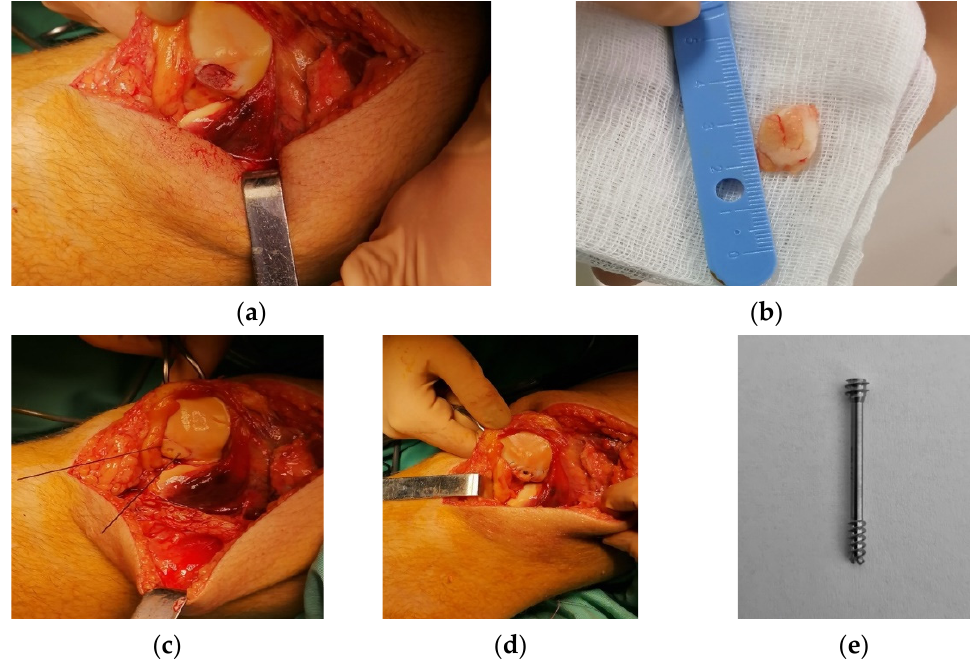
Figure 5. Details regarding the surgical techniques. ( a ) Highlighting of the patellar fracture; ( b ) the fractured fragment retrieved from the articulation and separated from the patient’s patella; ( c ) temporary fixation of the fractured fragment with K-wires; ( d ) internal fixation of the fractured fragment based on a headless titanium screw; ( e ) the titanium Herbert screw used for permanent fixation of the fracture.